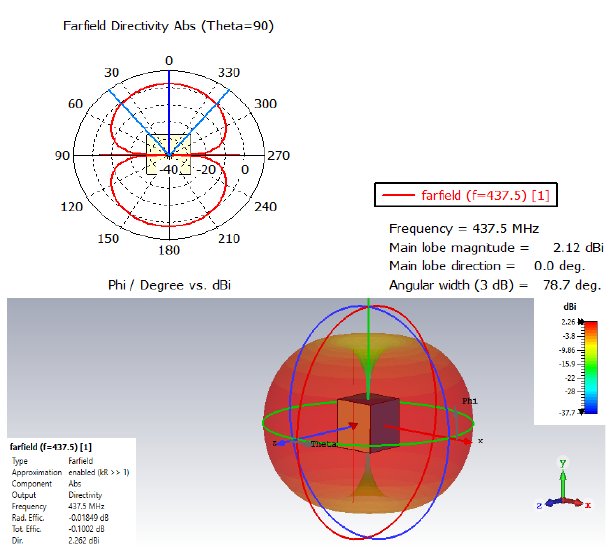
Figure 12(a) and 12(b). Polar and 3D radiation pattern plots for the optimized model of the half-wave dipole antenna with the metallic structure